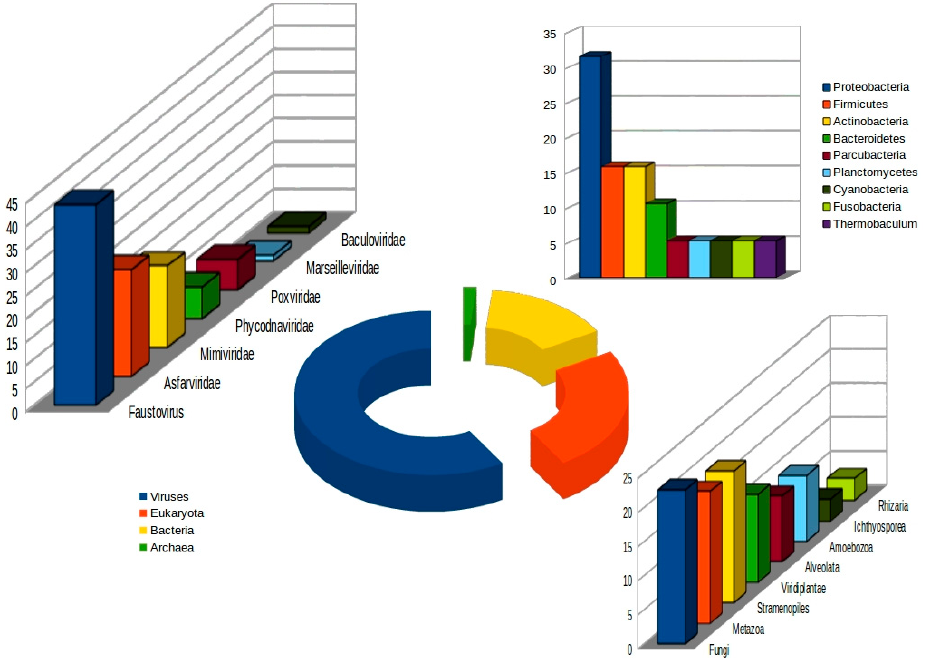
Figure 3. Distribution of the best-matching homologs to Kaumoebavirus proteins (the diagram shows only the 59% of genes with significant BLAST hits). Best-matching homologous proteins were determined using BLASTP (E value < 10 − 3 ) against the non-redundant (NR) database at the National Center for Biotechnology Information (NCBI).